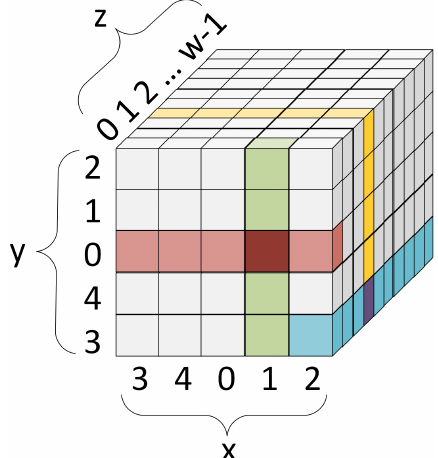
Figure 5. SHA-3 state as three-dimensional array A . In Figure